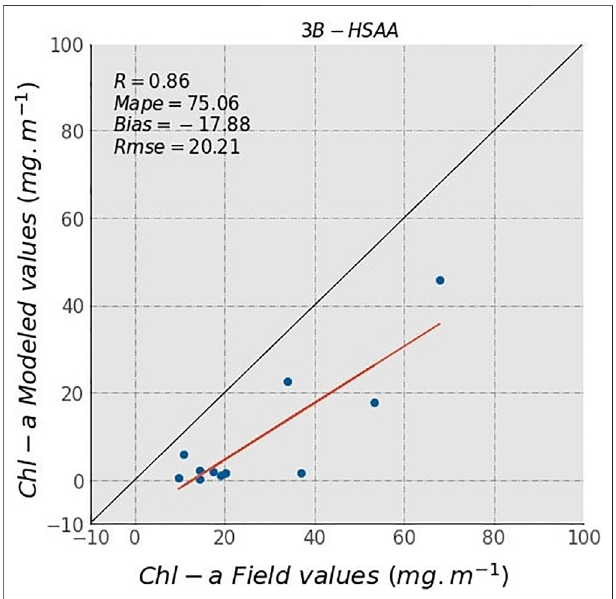
FIGURE 8 | Scatterplot between fi eld-measured Chl-a and estimated Chl-a with the HSAA-3B algorithm. Note that the sample size is lower due to negative values (n =